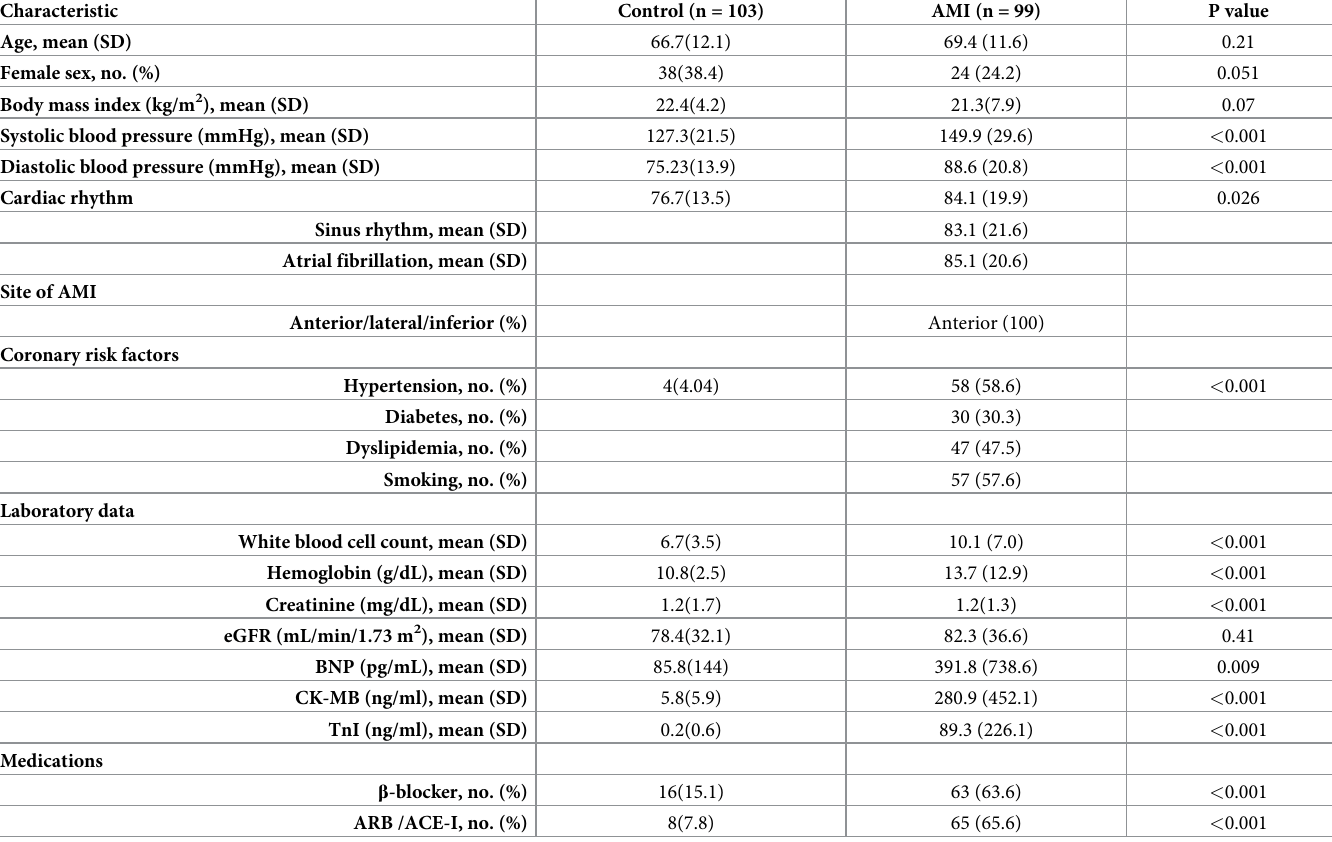
Table 1. Baseline clinical characteristics of the study cohort.